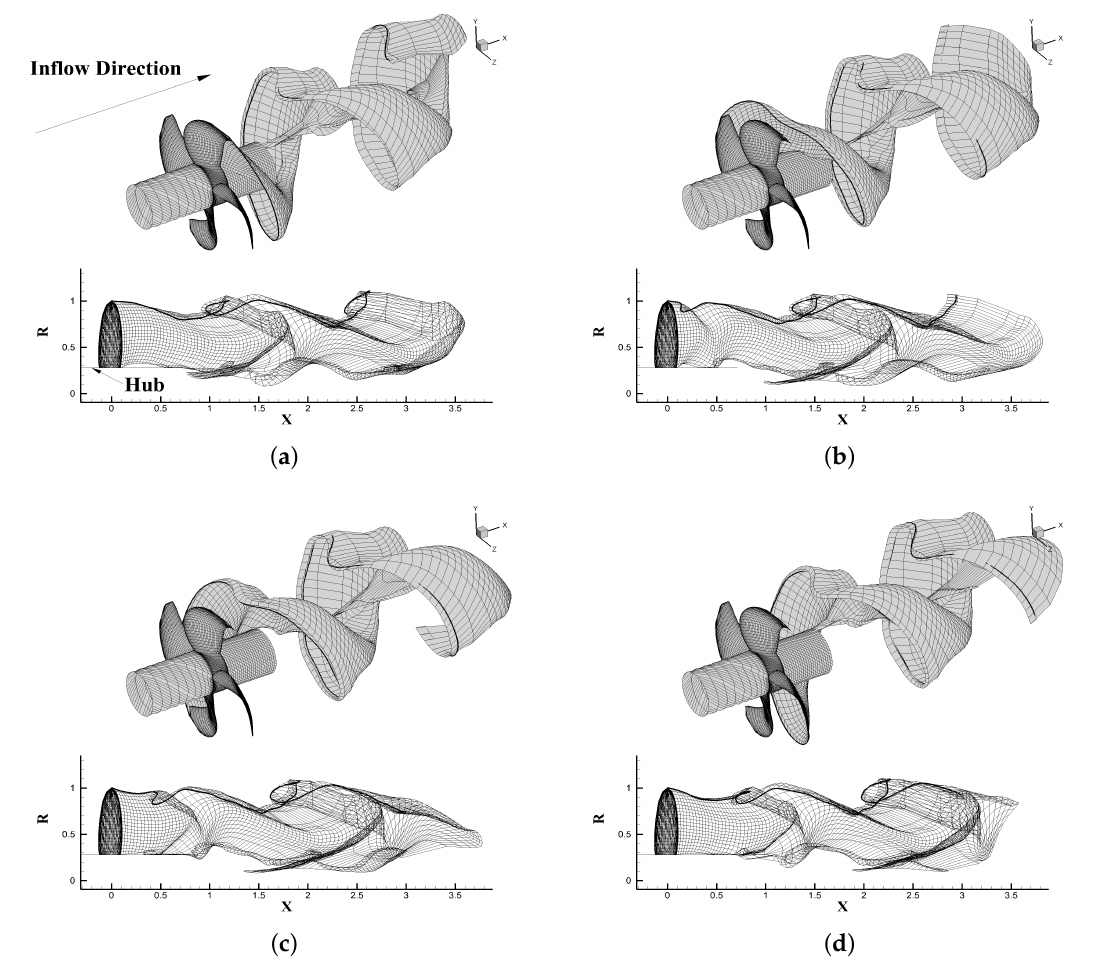
Figure 28. Fully aligned wake of SSPA P2772 propeller with infinite hub at the blade angle ( a ) 0 ◦ , ( b ) 90 ◦ , ( c ) 180 ◦ , and ( d ) 270 ◦ positions. Only the key wake is